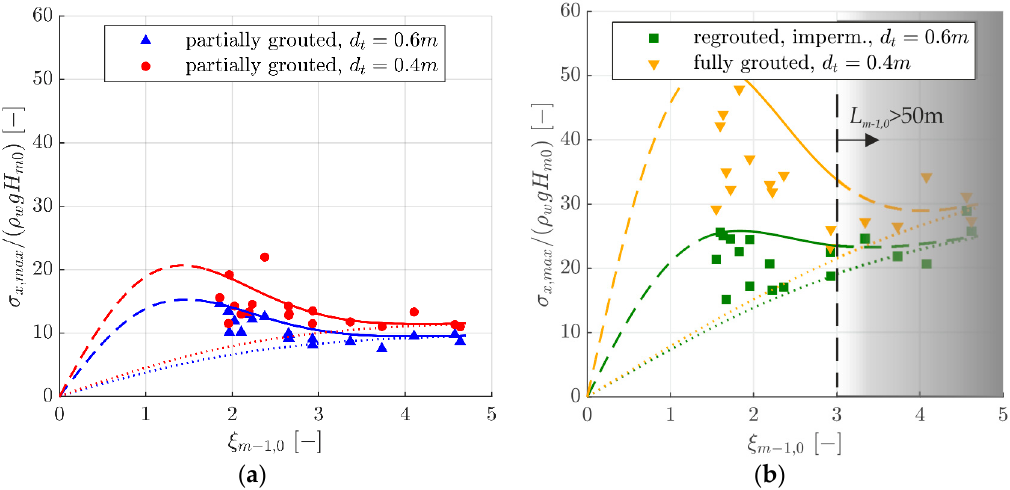
Figure 10. Maximum relative tensile bending stress σ x,max /( ρ w gH m 0 ) dependent on the surf similarity parameter ξ m − 1 , 0 with enveloping functions (parameter combination 2) for ( a ) permeable, partially grouted MGRR and ( b ) impermeable, regrouted and fully grouted MGRR (after [28]).